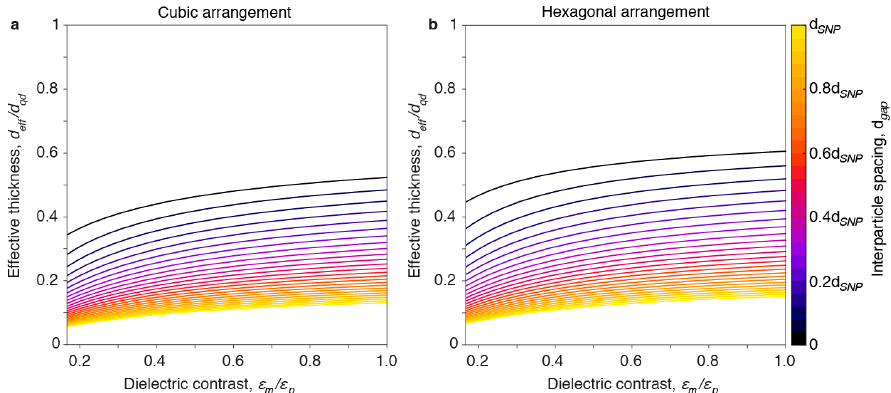
Figure 4. Simulated effective thickness of SNPs arranged in a monolayer. Effective thickness as a function of dielectric contrast ε m / ε p and interparticle spacing d gap for square ( a ) and triangular ( b ) lattice arrangement.